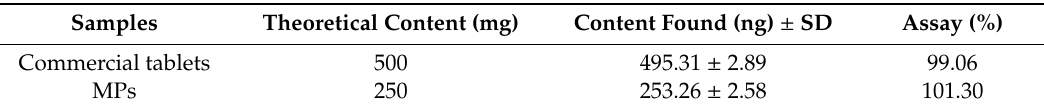
Table 6. Pharmaceutical assay of DIOM in commercial tablets and in-house developed MPs formulations (mean ± SD; n =